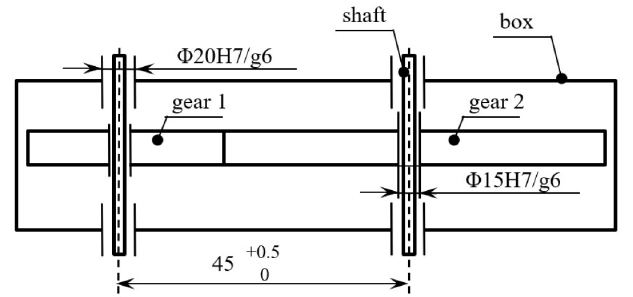
Fig. 7. Assembly condition of two gears with